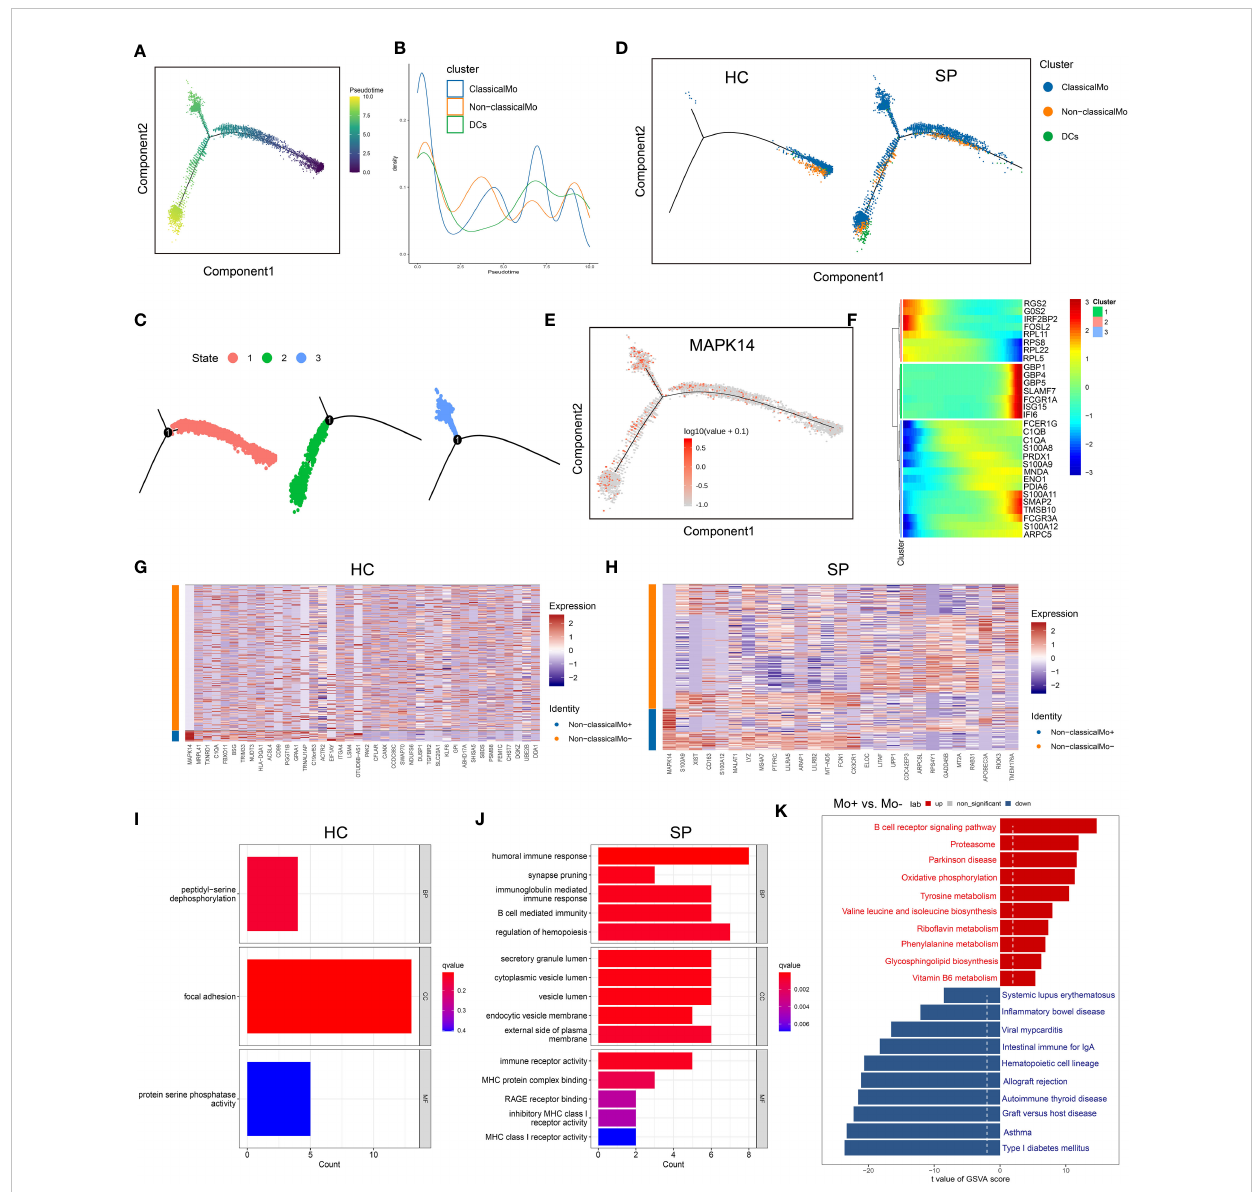
FIGURE 6 Trajectory and pseudo-time analysis of immune cells. (A) Monocle pseudotime trajectory of monocytes. (B) Curve plot showing the progression of classical monocytes, non-classical monocytes and DCs. (C) The pseudotime trajectory revealed 3 different states of monocytes. (D) Monocle pseudotime trajectory showing the progression of classical monocytes, non-classical monocytes and DCs in HC and SP. (E) Monocle pseudotime trajectory of MAPK14. (F) The clustering and expression kinetics shows top 30 representative DEGs along the main stem of the pseudotime trajectory. (G) Heatmap showing the top 40 DEGs between non-classical monocytes and non-classical mo - cells in HC. (H) Heatmap showing the top 40 DEGs between non-classical monocytes and non-classical mo - cells in SP. (I) Bar graph of GO Enrichment analysis in HC. (J) Bar graph of GO Enrichment analysis in SP. (K) Bar plot of GSVA analysis (Mo+ vs